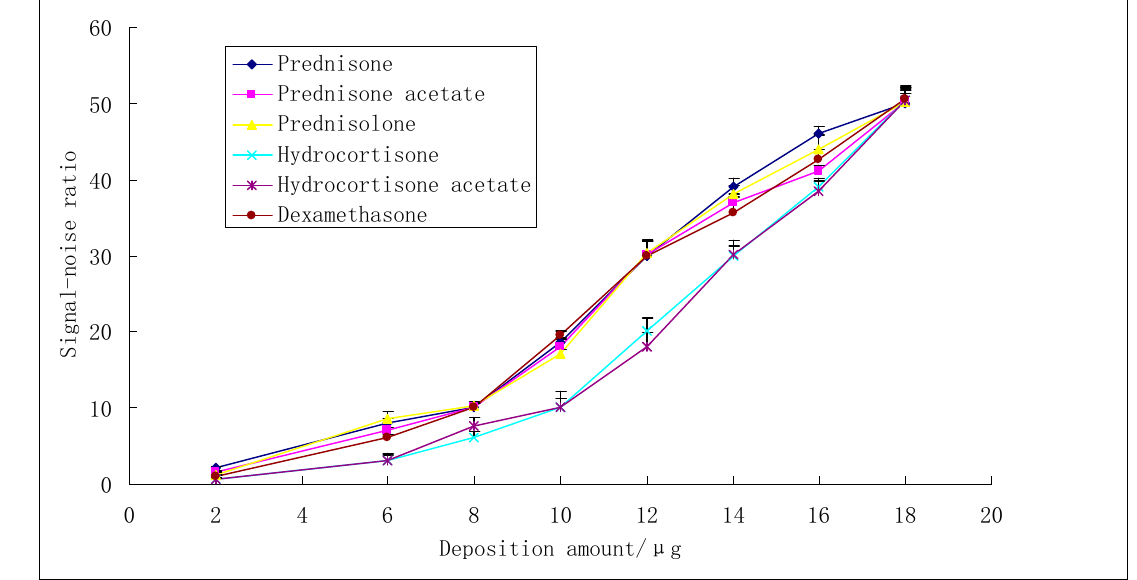
Figure 8. The LOD analysis of six reference substances.